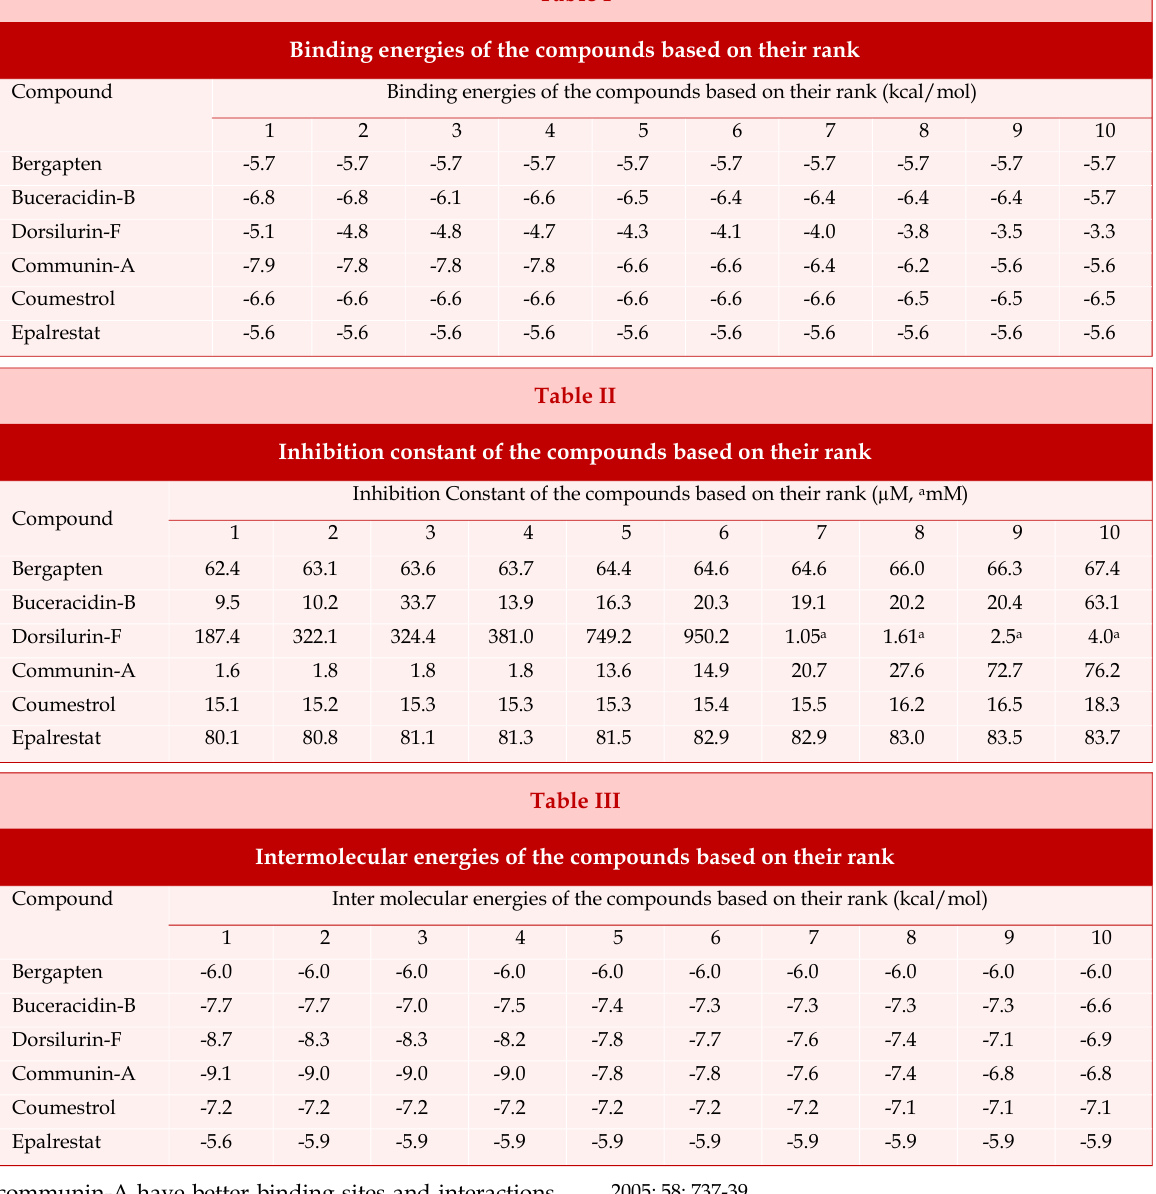
communin-A have better binding sites and interactions with aldose reductase enzyme.